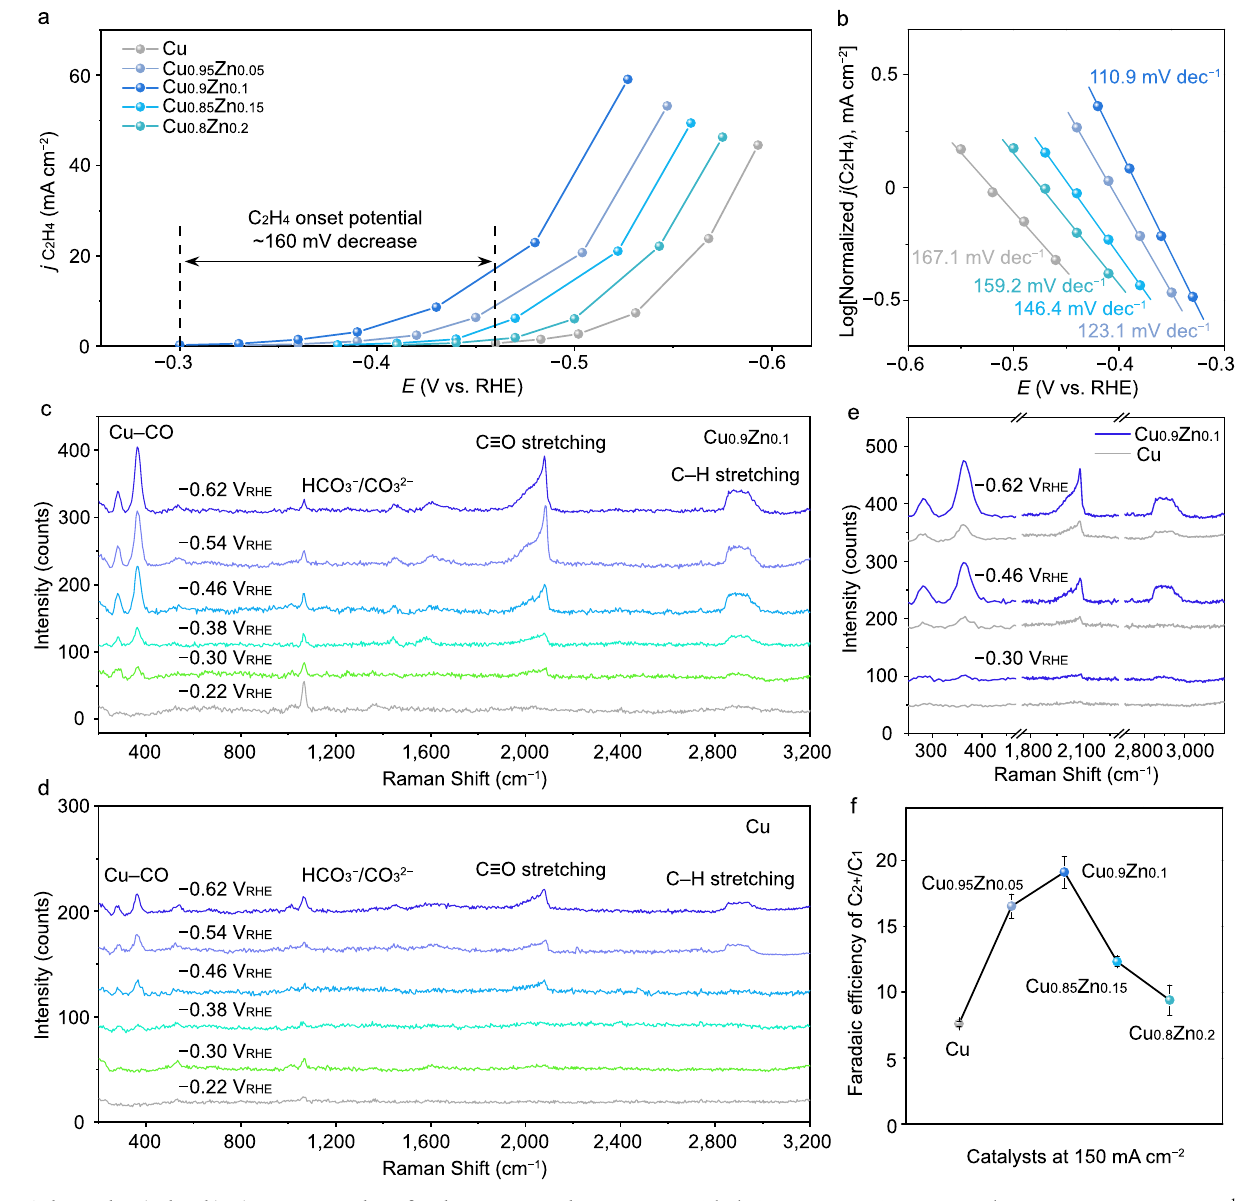
Fig. 2 | Electrochemical and in situ Raman analyses for the co-sputtered Cu y Zn 1 − y (y=0.95, 0.9, 0.85, 0.8) and Cu catalysts in 0.75M KOH electrolyte. a The C 2 H 4 partial current density nearthe onset potentials. b Tafel plots for C 2 H 4 . In situ Raman peaks for CO adsorption on c Cu 0.9 Zn 0.1 and d Cu at various